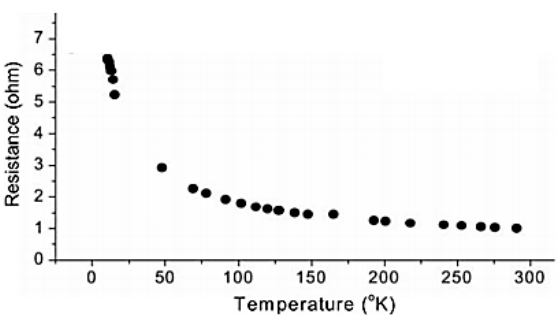
Figure 7. Resistance–temperature curve of a cryogenic sensor based on CNTs vertically grown by CVD method [32], reprinted by permission of the publisher (Taylor & Francis Ltd)